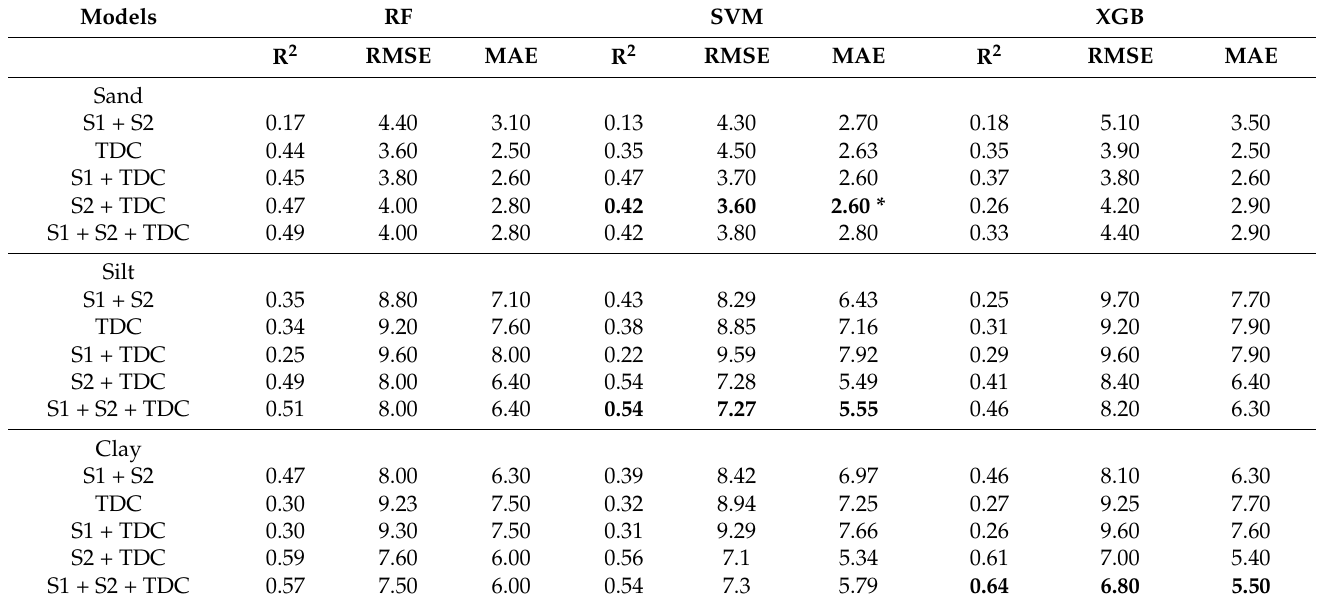
Table 3. Model accuracy for soil texture fractions in the SA